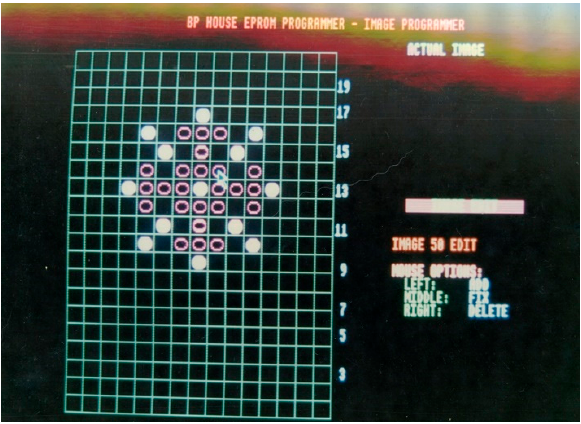
Figure 10. Screenshot of the program Dahms developed to allow Ostoja to “program” the Christmas star. Published with permission. Image courtesy Russell Dahms.